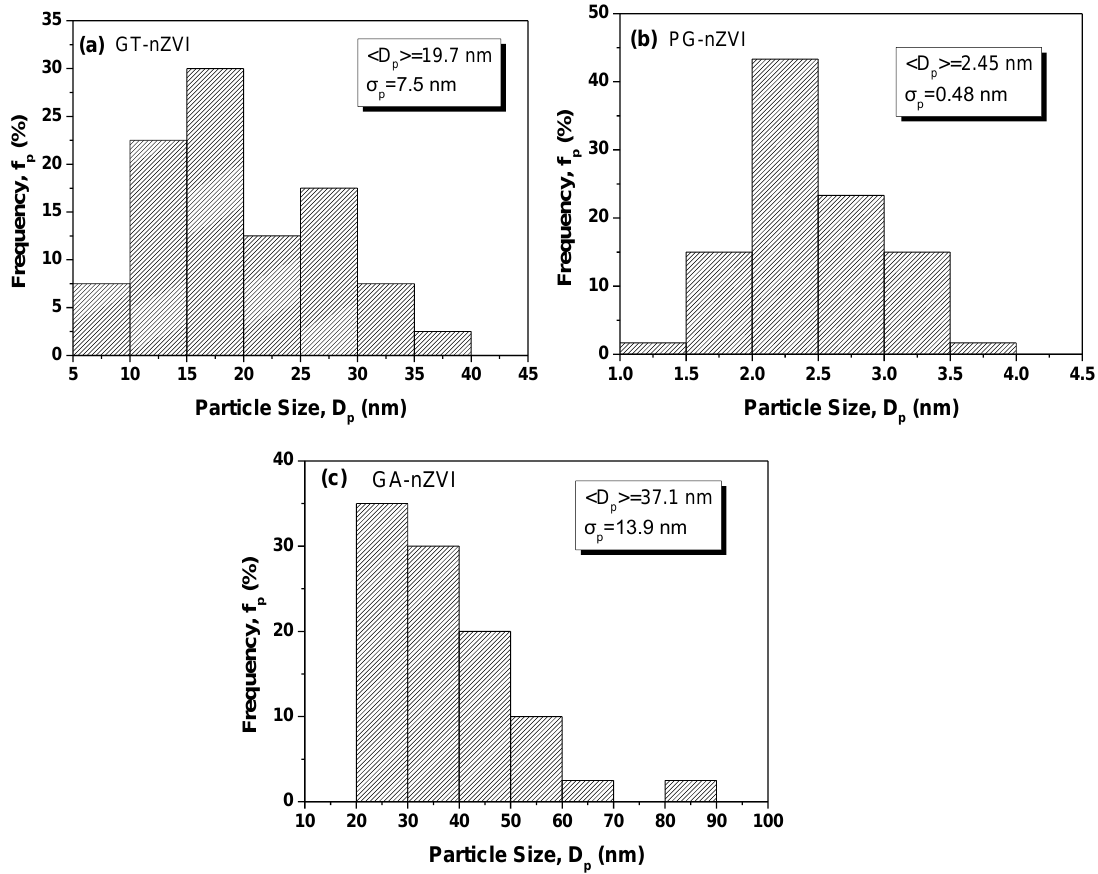
Figure 6. Statistics of the nanoparticle size distributions measured with analysis of TEM images: (a) GT-nZVI, (b) PG- nZVI, (c)